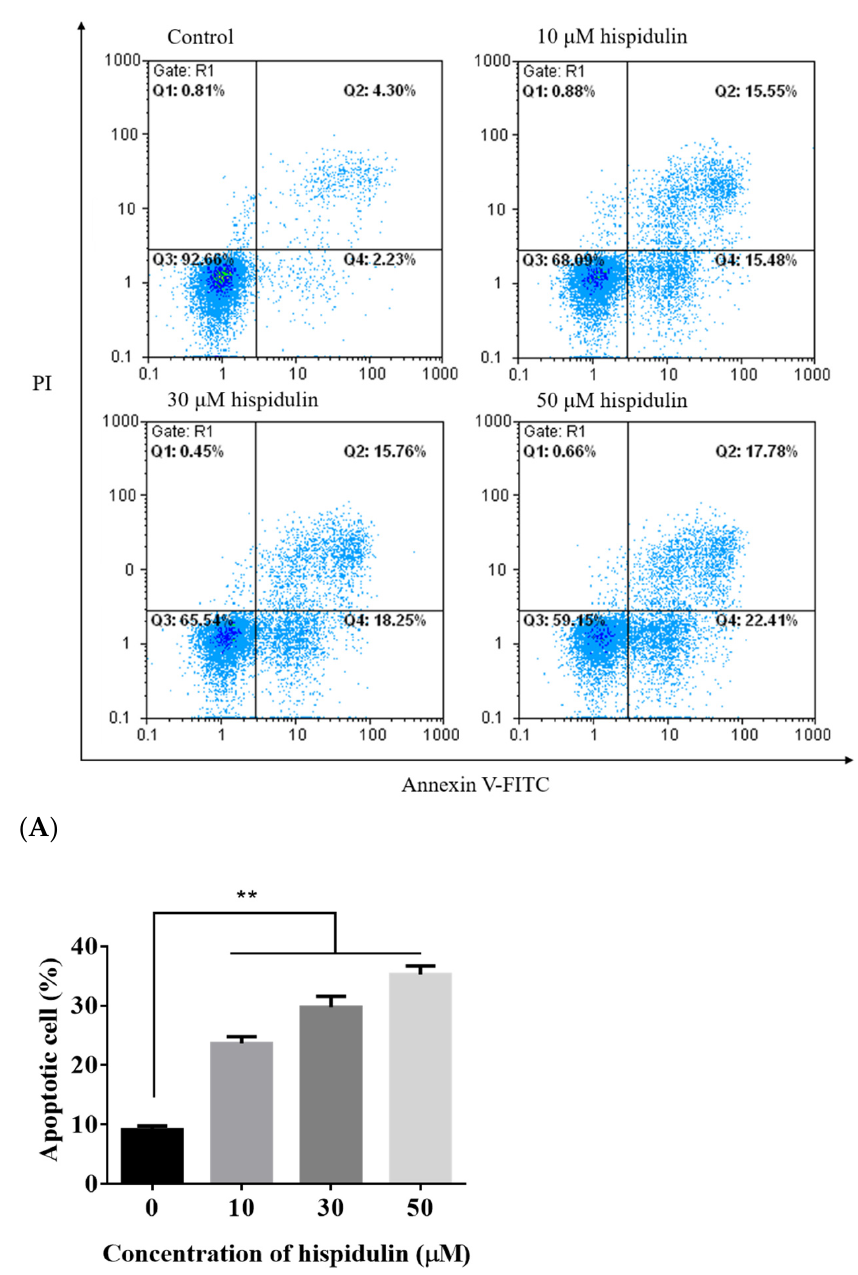
Figure 3. ( A ) The effect of hispidulin on cell apoptosis in A2058 cells as determined by flow cytometry. A2058 cells were treated with indicated concentrations (0, 10, 30, and 50 µM) of hispidulin for 24 h followed by double-staining with Annexin V/FITC and PI for flow cytometric analysis to determine the proportion of apoptotic cells. The flow cytometry profile presents Annexin V-FITC ( x -axis) and PI staining ( y -axis). The values represent the percentage of cells in each of the four quadrants (lower left quadrant: viable cells, upper left quadrant: necrotic cells, lower right quadrant: early-stage apoptotic cells, and upper right quadrant: late-stage apoptotic cells). ( B ) The apoptotic cells were quantified with early-stage and late-stage apoptotic cells. Data are presented as percentage of control and mean ± SE, with ** p < 0.01 compared with the control group (n = 6).